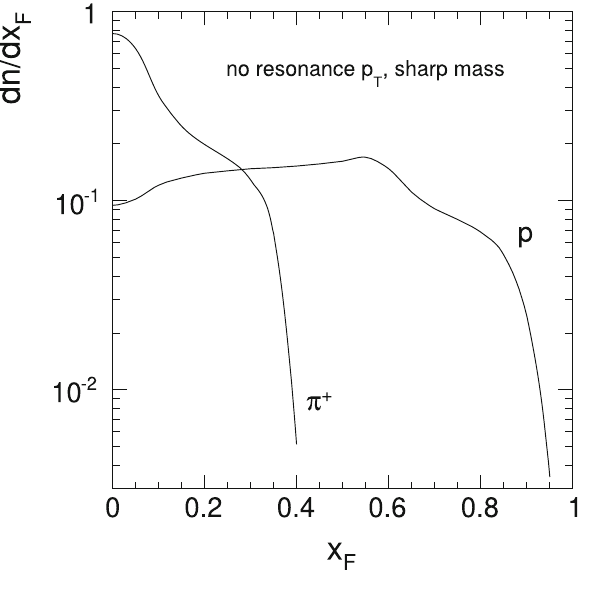
For dn / dx F there is no noticeable variation both for pro- tons and for pions as compared to Fig. 152 without resonance p T